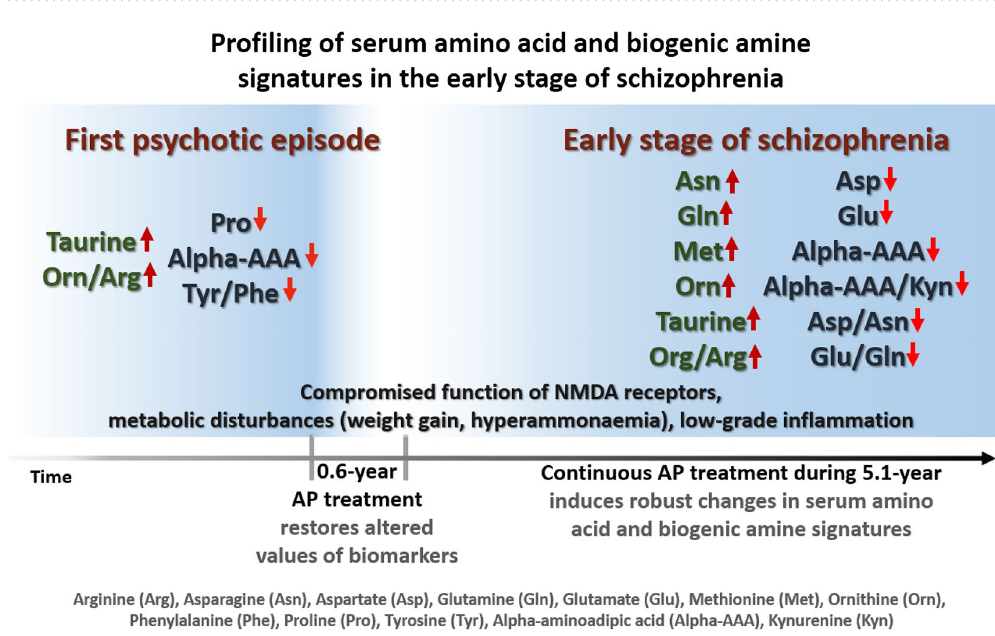
Figure 3. Schematic overview of the main results of the